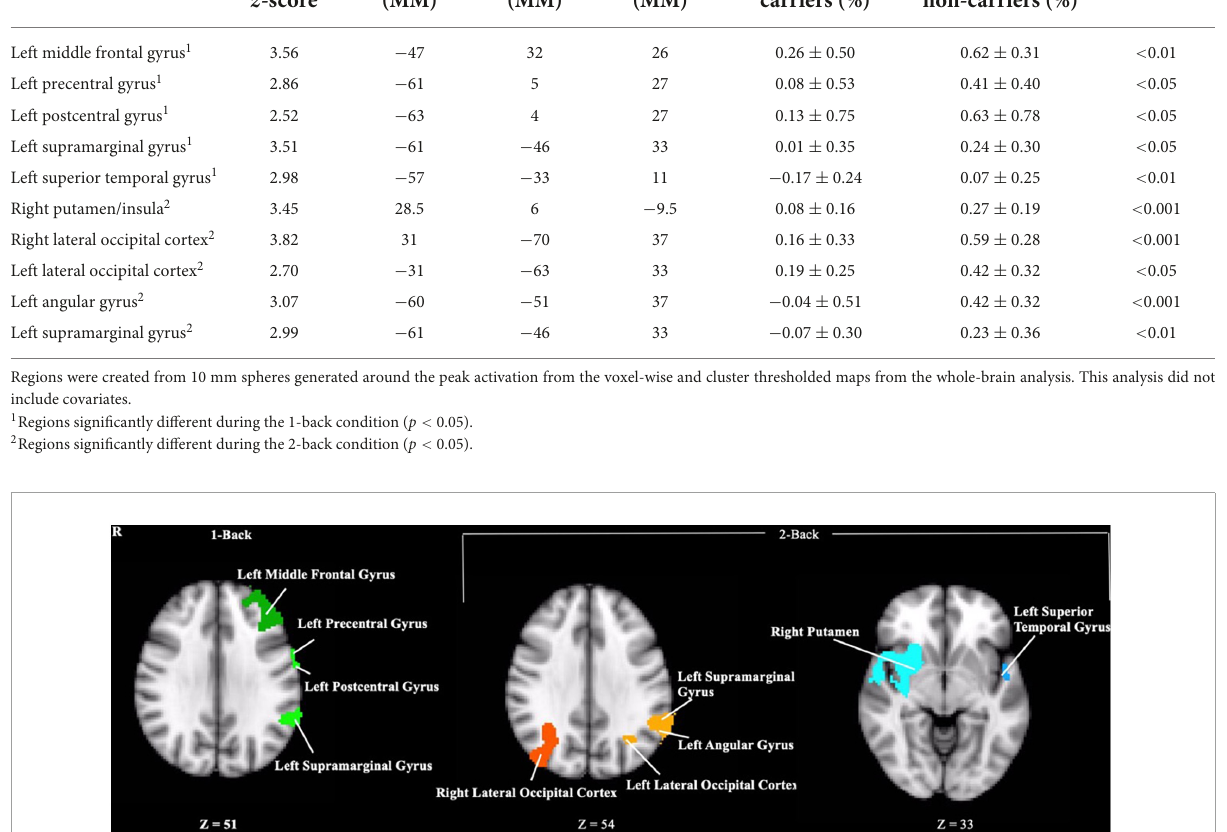
n-back data by examining brain regions in which BMI was associated with greater activation, and lower activation, for each condition of the n-back task. Using a voxel-wise z -score of 2.3 and a cluster threshold of p < 0.05, BMI was